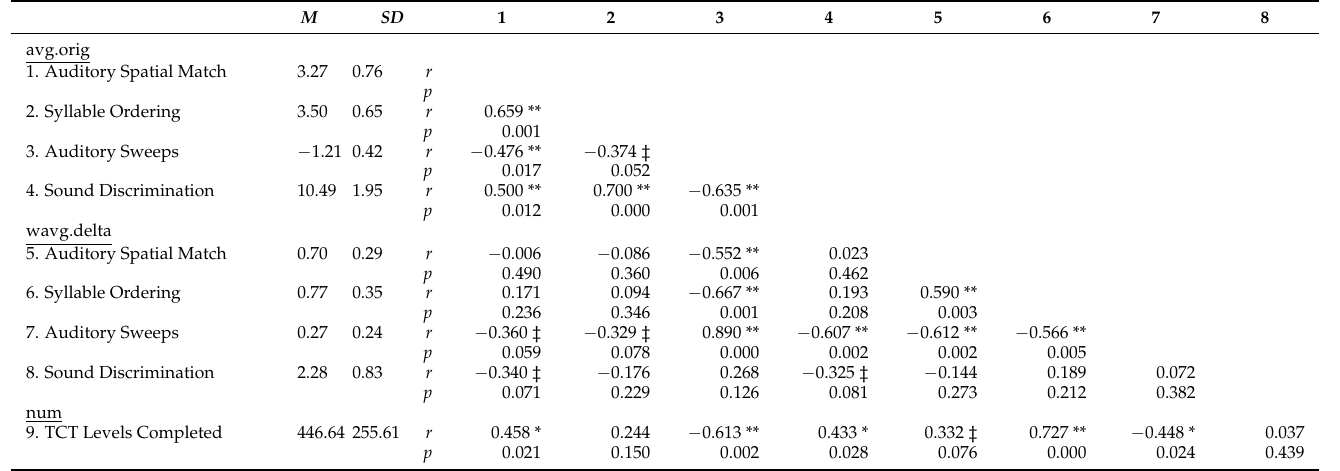
Table 2. Partial Correlations between TCT Performance